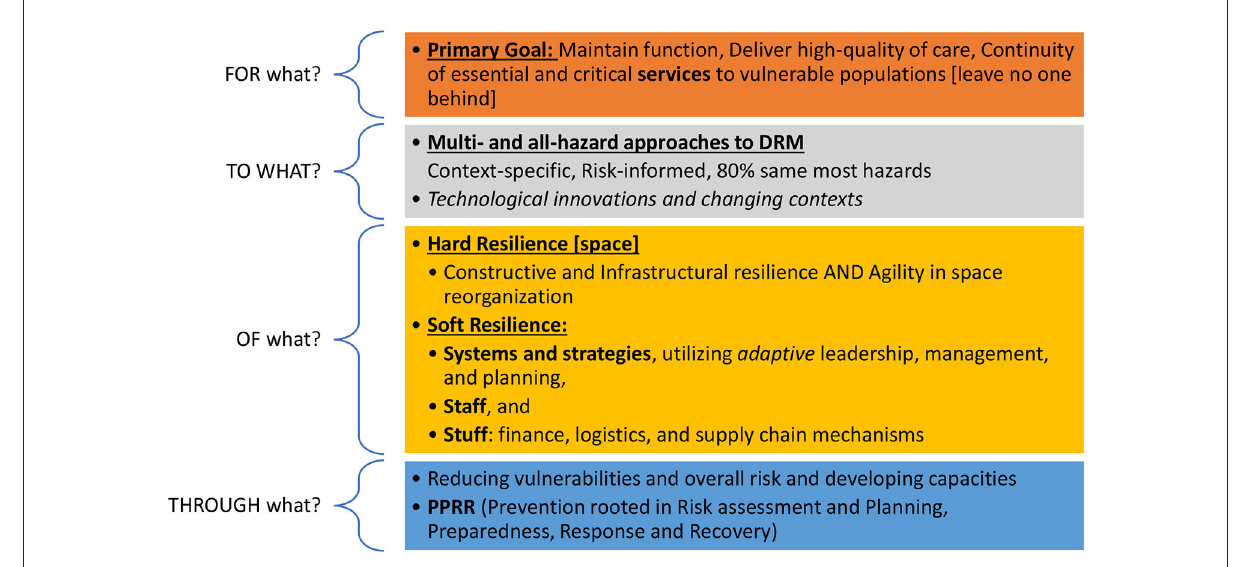
FIGURE5 Operationalizing hospital resilience, adapted from Wiig et